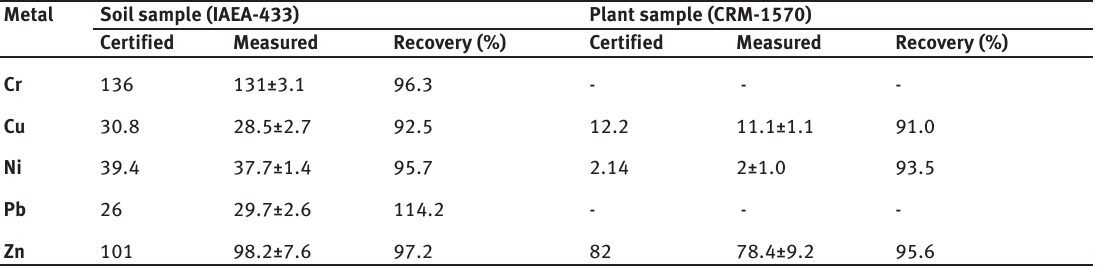
Table 1: Recovery analysis of heavy metal concentrations (μg g -1 ) in soil and plant certified reference materials. Metal Soil sample